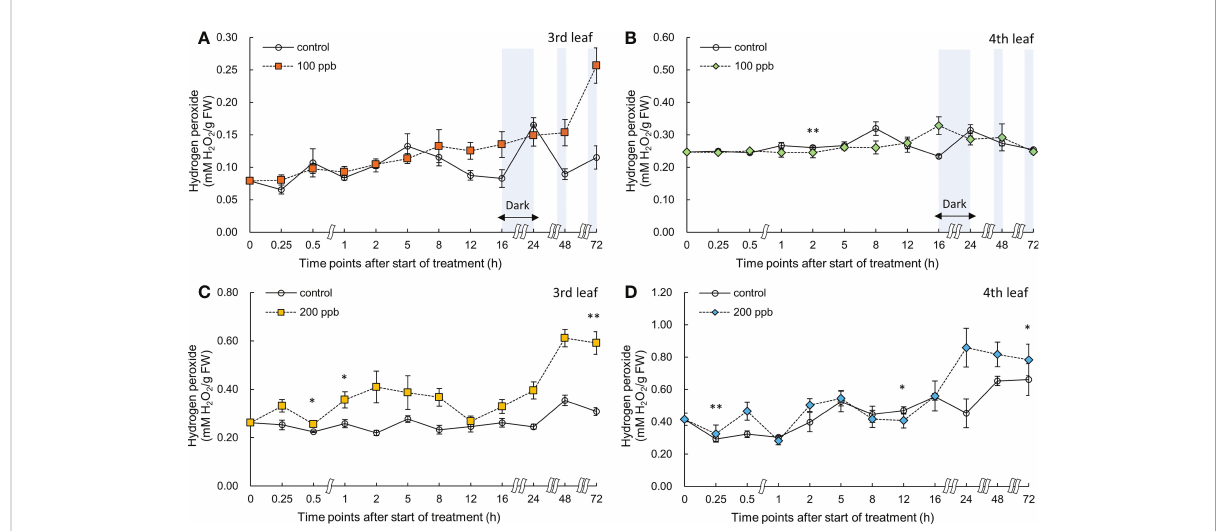
FIGURE 10 Hydrogen peroxide of third (A, C) and fourth (B, D) red leaf lettuce subjected to 100- and 200-ppb ozone treatment for 72 h. The vertical vars indicate SE (n=4). Statistically signi fi cant differences are indicated at * p < 0.05 and ** p < 0.01 by